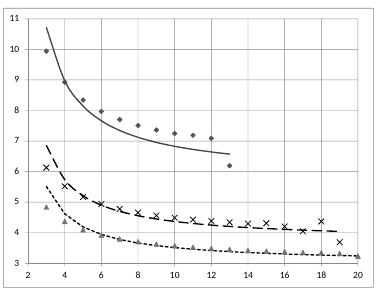
Figure 2. Ratios of the errors for T = 1 (W), T = 2 ( × ) and T = 3 ( (cid:78) ) and theoretical ratios if the convergence rate was CN − 3 / 2 r − N with r = 5 . 83 (continuous line), r = 3 . 73 (dashed line) and r = 3 (dotted